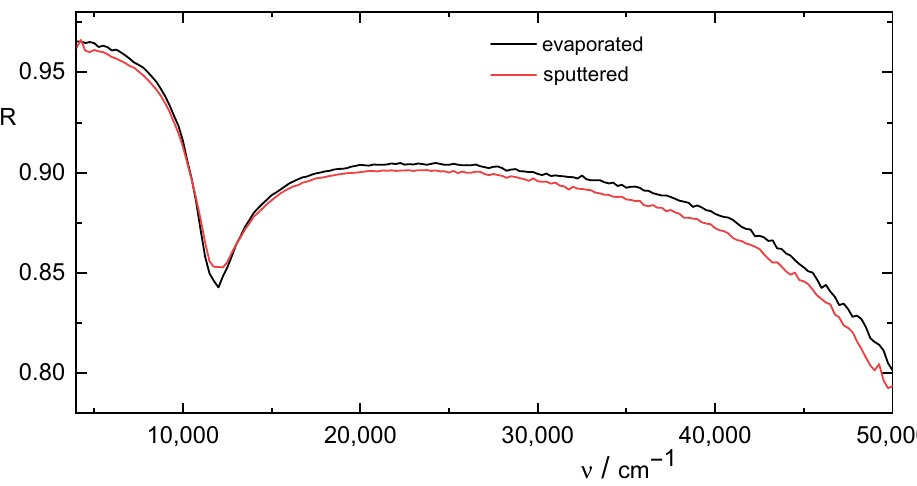
Figure 10. Near normal incidence reflection spectra of a sputtered and an evaporated sample. The thickness of both samples turned out to be 29.7 nm.